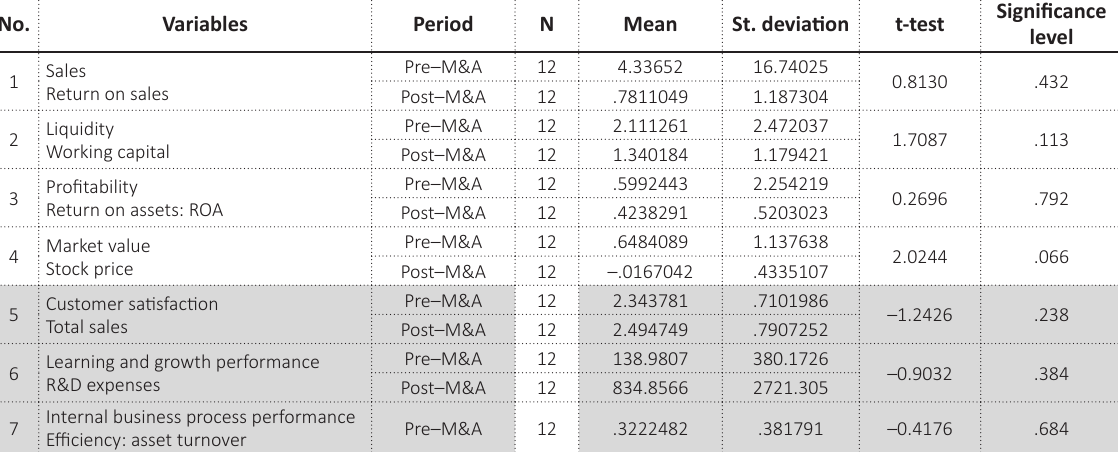
Table 2. T-test analysis to differentiate between pre- and post-M&A results for the BSC model